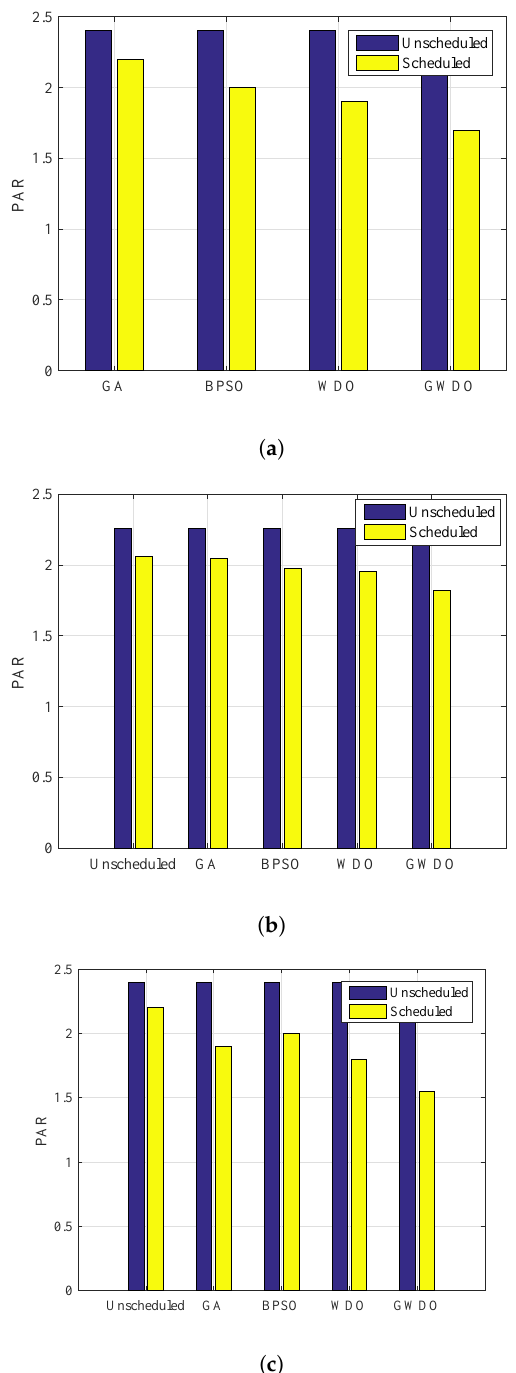
Figure 16. PAR analysis: ( a ) Without RESs and ESS; ( b ) With RESs; ( c ) With RESs and